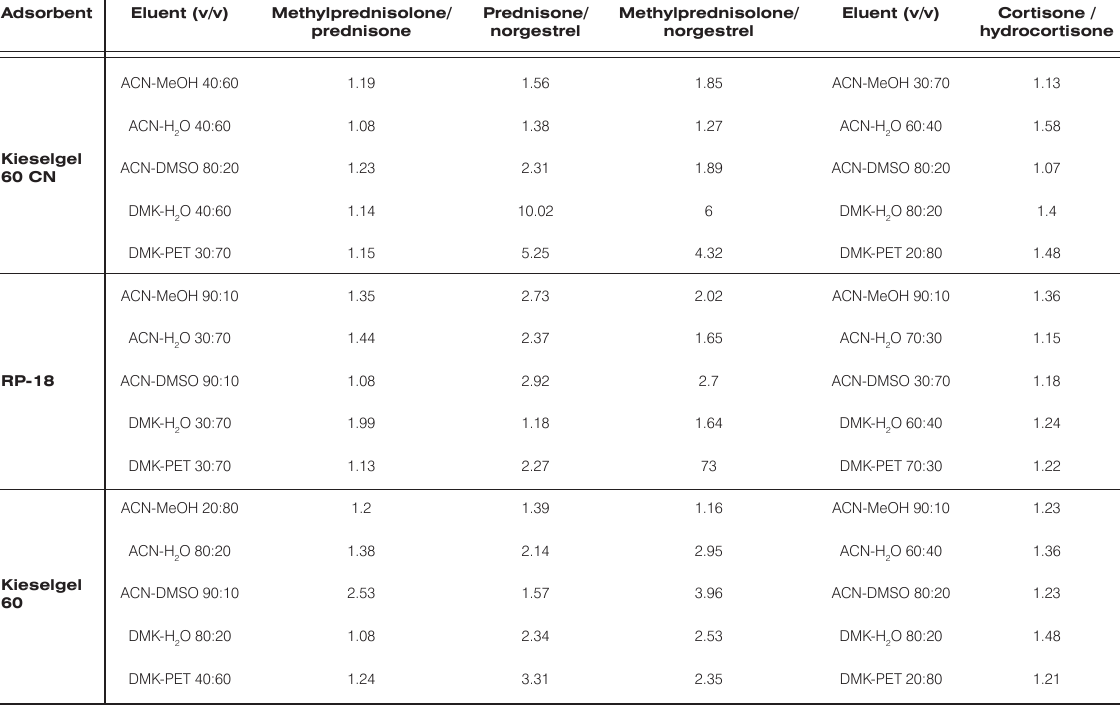
Table 2. The highest values of the parameter α fo r prednisone, methylprednisolone, norgestrel and for cortisone and hydrocortisone, using different mobile phases (v/v). Adsorbent Eluent (v/v) Methylprednisolone/ Prednisone/ Methylprednisolone/ Eluent (v/v) Cortisone / prednisone norgestrel norgestrel hydrocortisone